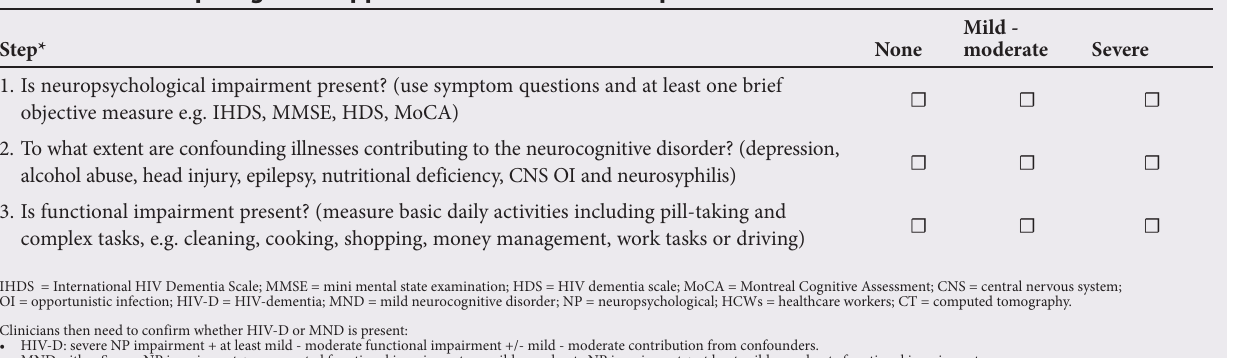
Table 4. Three-step diagnostic approach to HAND in clinical practice